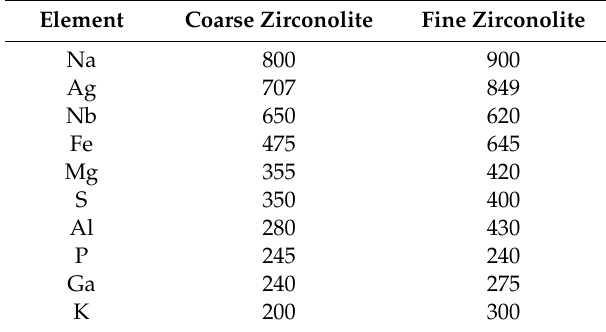
Table 3. Minor elements ( > 100 ppm) in the zirconolite feed samples in